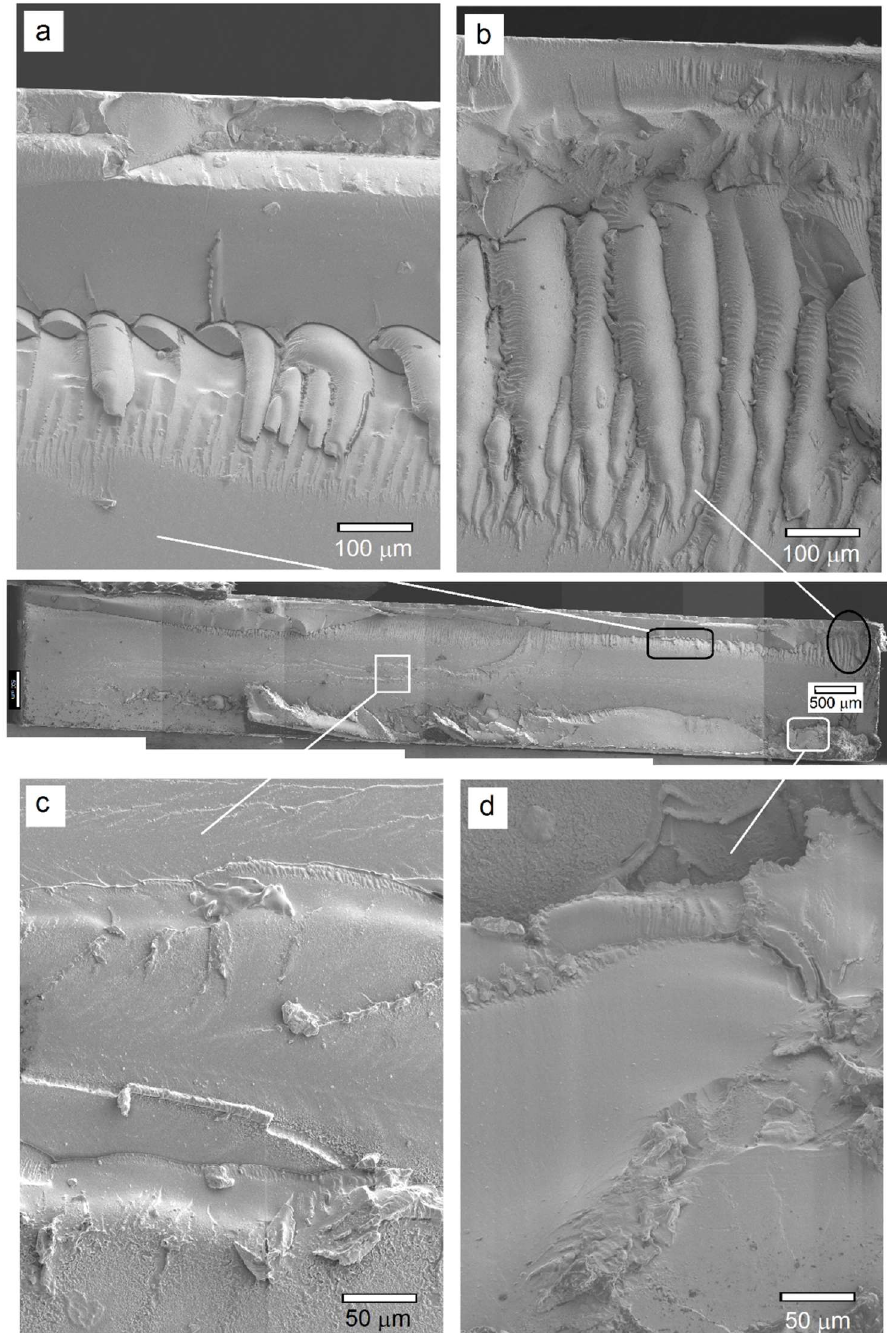
Figure 10. (Center) SEM cross-sectional view of the fractured PC/TiO 2 -0.5NP composite: ( a , b ) Near- surface regions indicating crazing and matrix degradation; ( c ) large, relatively smooth region in the mid-section demonstrating smooth cleavage failure due to matrix softening and flow; ( d ) rough, grainy appearance near the back surface of test specimen.